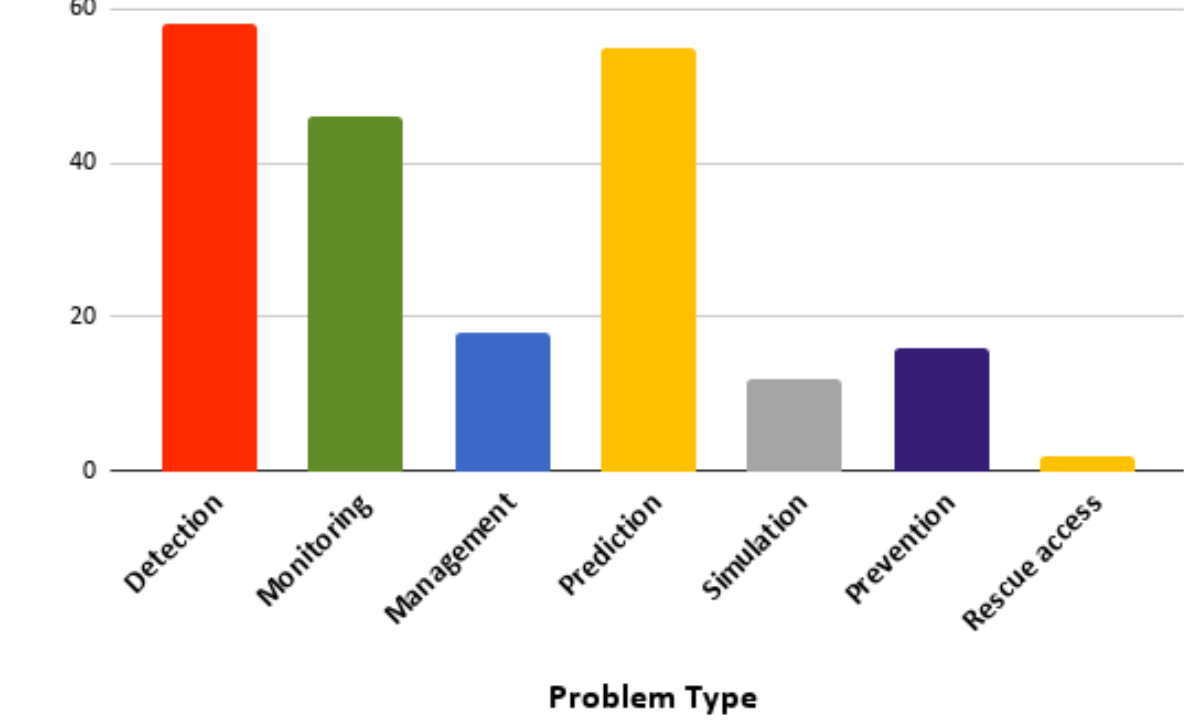
Figure 6. Number of studies found versus the problem to be solved. RQ2. What types of DSS were used ?